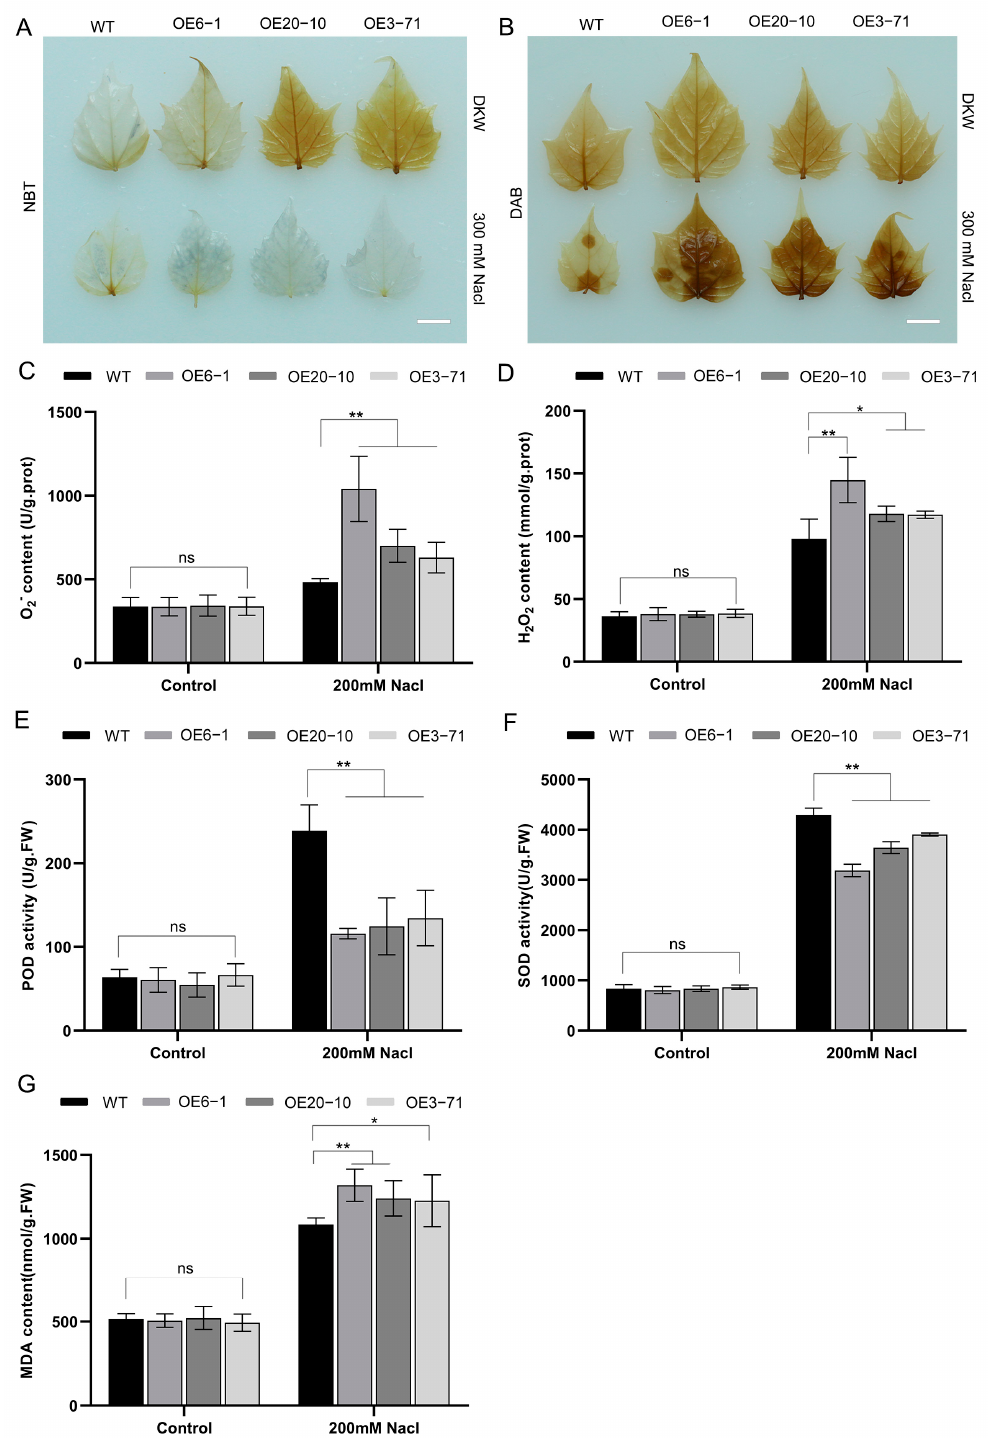
Figure 8. Overexpression of CbWRKY27 enhances the ROS accumulation under salt treatment. The six-week-old seedlings were subjected to 300 mM NaCl treatment (A-B). The 18-week-old seedlings were subjected to 200 mM NaCl treatment (C-G). NBT staining ( A ), DAB staining ( B ), O 2 − contents ( C ), H 2 O 2 contents ( D ), MDA contents ( E ), POD contents ( F ), and SOD contents ( G ) were measured in the WT and OE lines after salt treatment. Bar = 1cm. The data represent the means ± SD ( n = 5), * p < 0.05 and ** p < 0.01 using Student’s t -test.